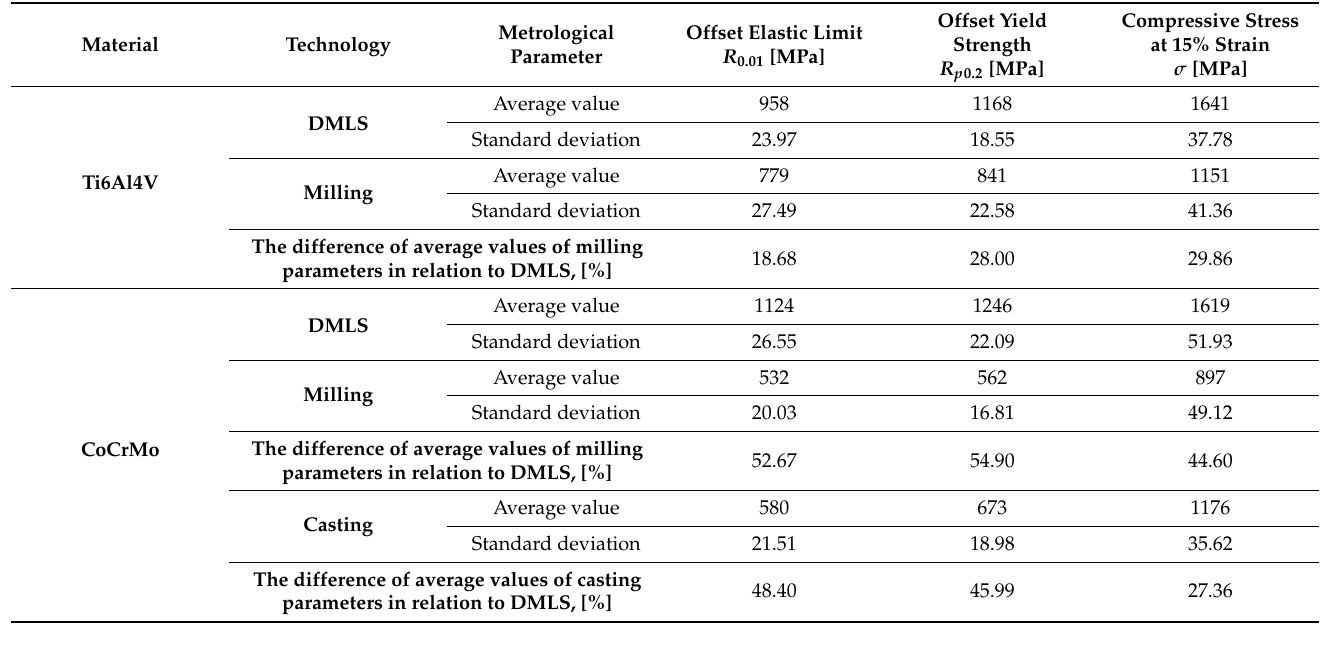
Table 2. List of strength parameters of the tested biomaterials, depending on the manufacturing technology, in axial compression tests.